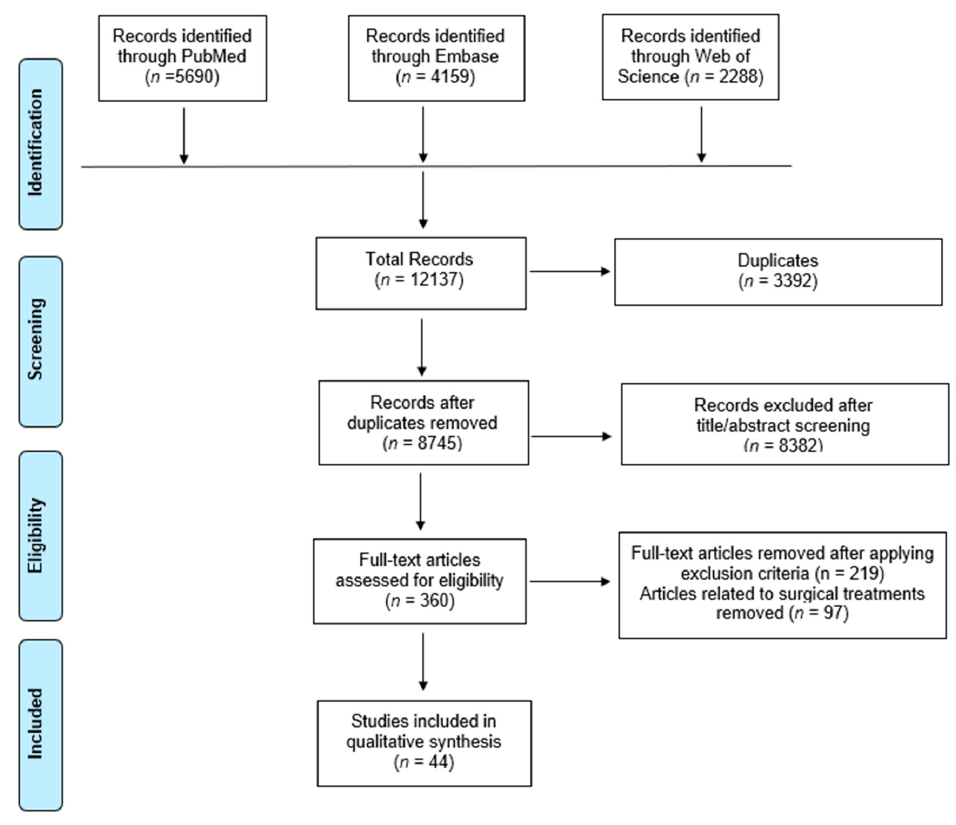
Figure 1. Flowchart showing selection of articles pertaining to tibialis posterior tendinopathy for scoping review and qualitative analysis. Table 2. Characteristics of included studies.